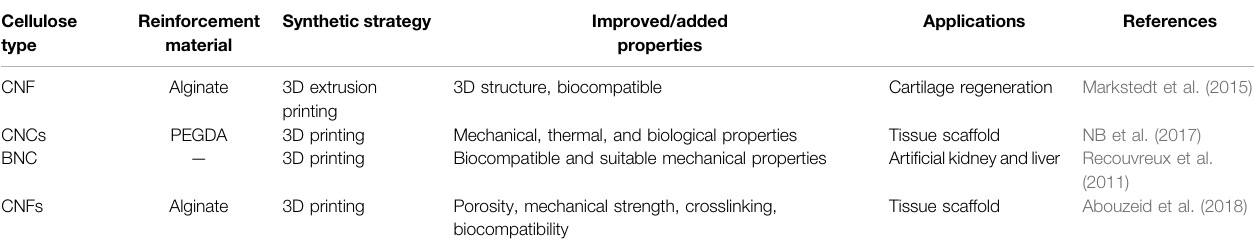
TABLE 6 | The improved properties, 3D printing, and biomedical applications of different nanocellulose-based composites. Cellulose